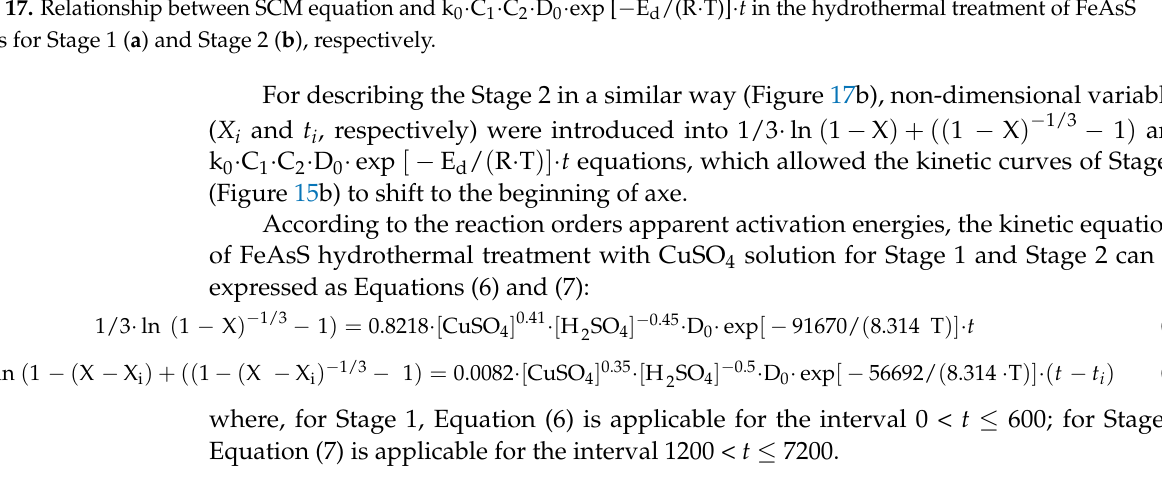
process for Stage 1 ( a ) and Stage 2 ( b ),